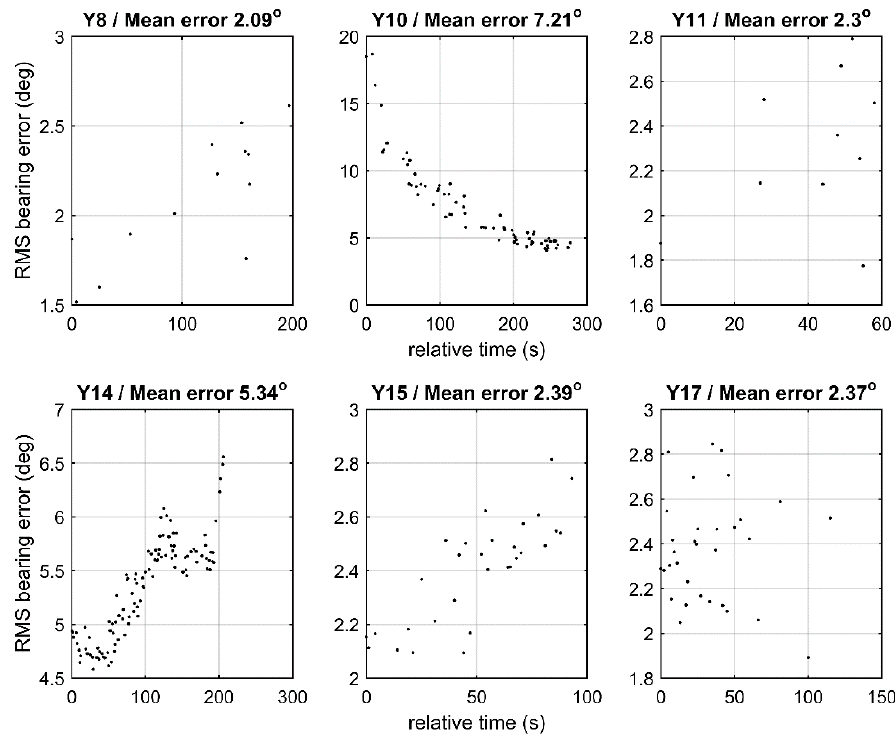
Figure 23. Bearing estimation RMS errors for sperm whale Y during stations Y8, Y10, Y11, Y14, Y15, and Y17.